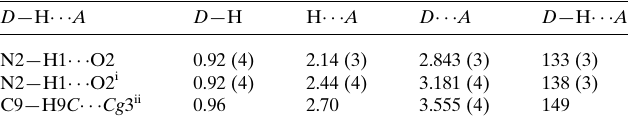
Table 1 Hydrogen-bond geometry (A˚ , (cid:3) ). Cg 3 is the centroid of the C10–C15 phenyl ring.